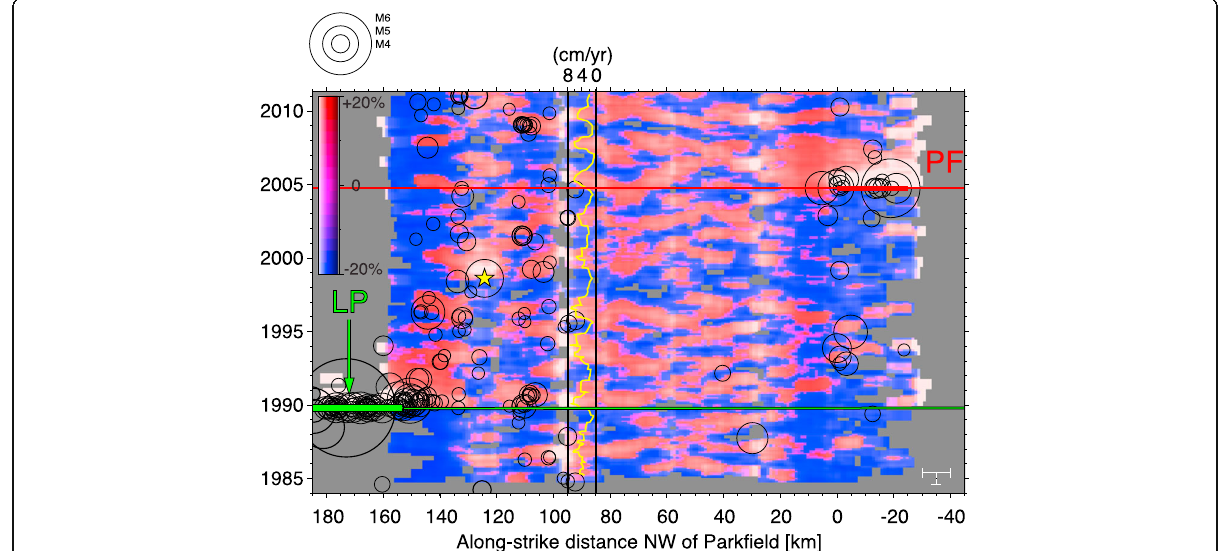
Fig. 11 Periodic slip rate change observed along the San Andreas fault (after Turner et al. (2015)). The slip rate is denoted by color and in percent difference from the average long-term rate. Red and blue indicate slip rates higher or lower than the long-term average. White indicates higher uncertainty associated with fewer repeating earthquake sequences or with rapidly changing rates. White bars at the lower right show the spatial and temporal smoothing windows used. Thick and thin horizontal bars show the rupture extent and timing of The Loma Prieta (LP, in green) and Parkfield (PF, in red) earthquakes. Circles show earthquakes along the fault (M ≧ 3.5) that are scaled along with their magnitude (see scale at top left). The yellow highlighted trace shows the slip rate history (given in absolute terms) in the section from 85 to 95 km NW of